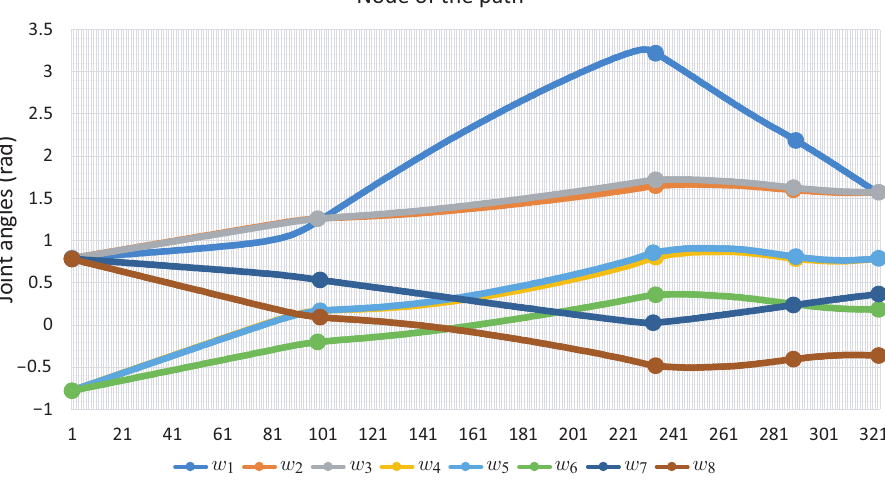
Figure 16. Joint angle motion for Case Study